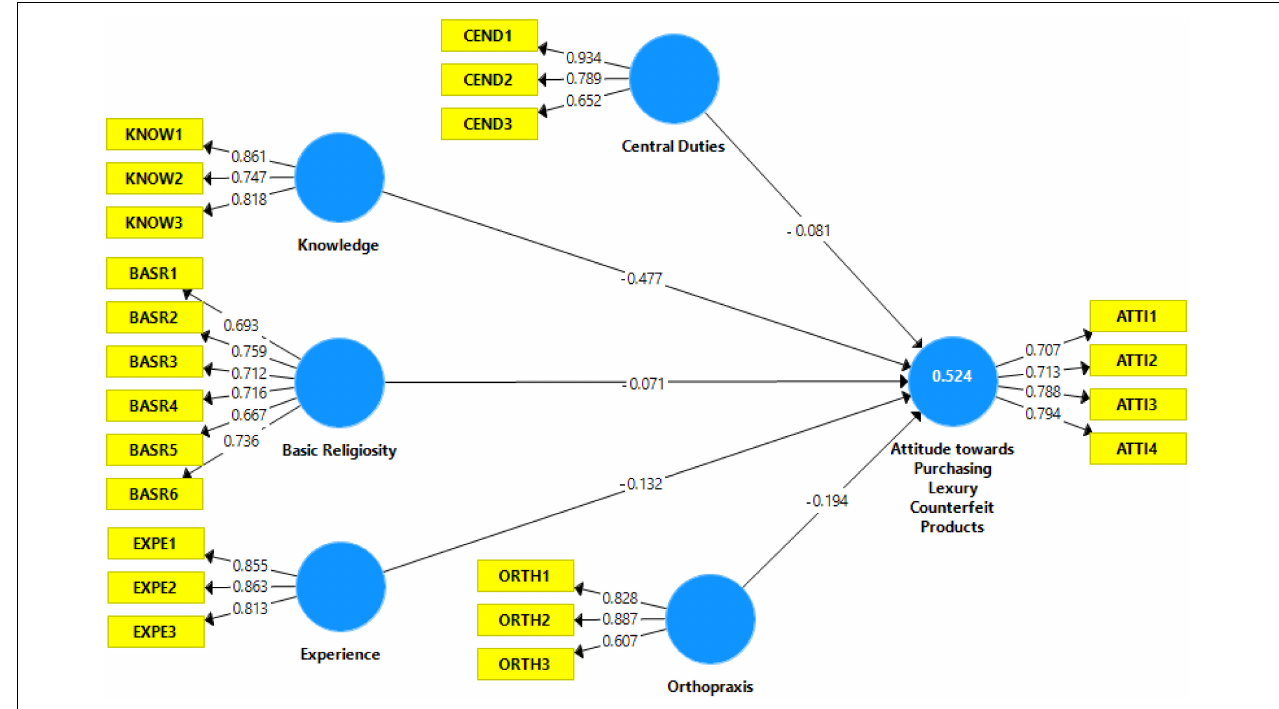
FIGURE 2 | Structural model (bootstrapping